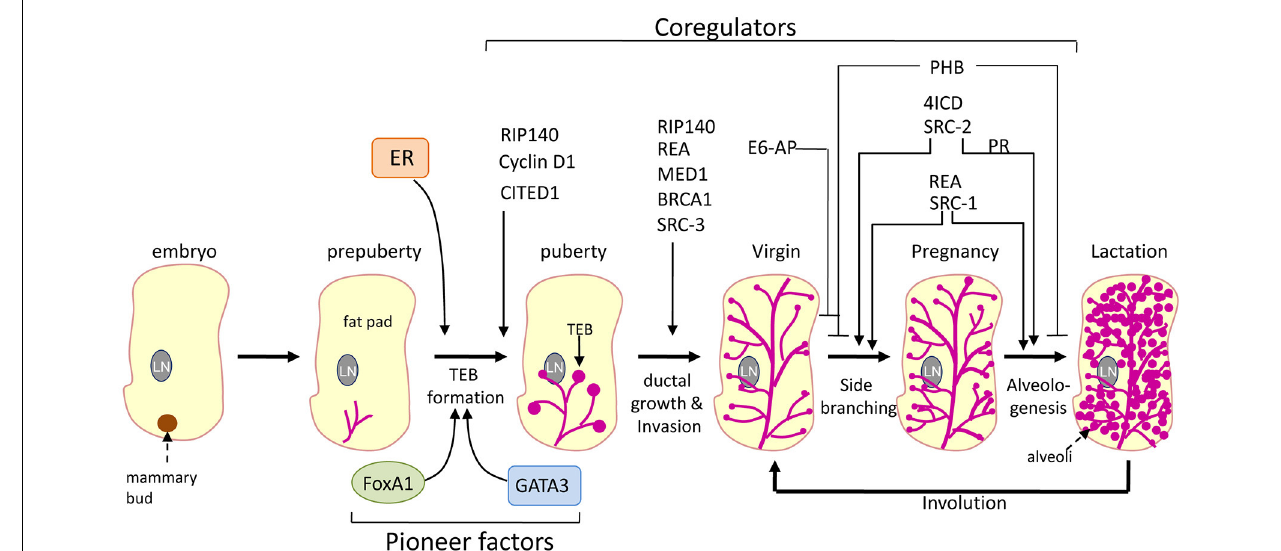
FIGURE 2 | Role of coregulators and pioneer factors in mammary gland development. Schematic representation of the role of various coregulators and pioneer factors of ER on different stages of mammary gland development. The thin arrows points to the developmental defects at these